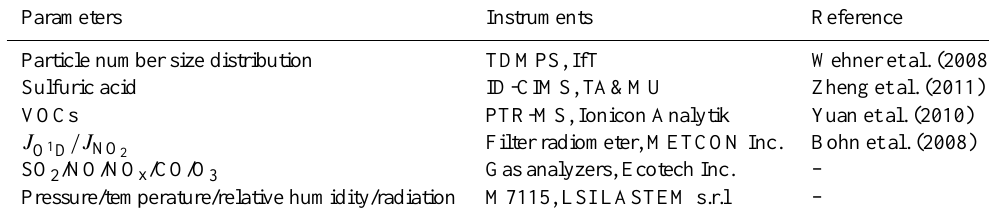
Table 1. Atmospheric parameters and instrumentation from the CAREBeijing 2008 campaign that are used in this study.